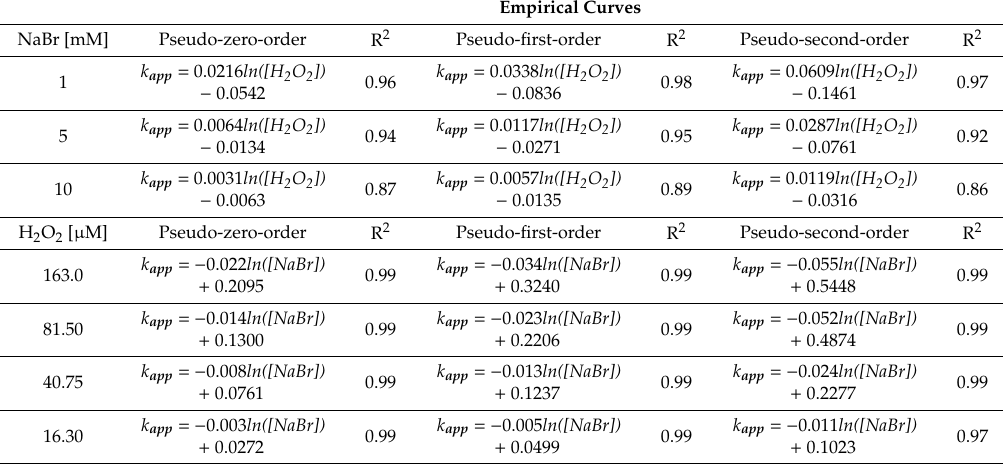
Table A2. Equations for the evaluation of the apparent rate coe ffi cients in Equation (A1), assuming pseudo-zero, -first, or -second-order reaction derived from the NaBr-KBr experimental